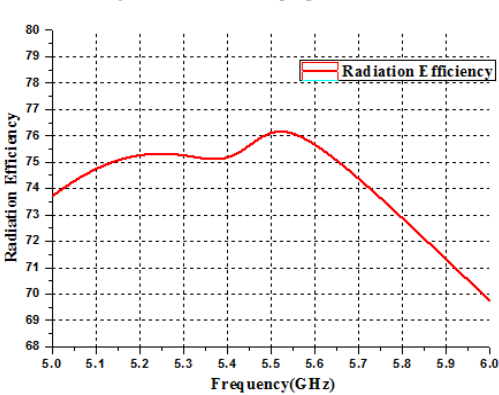
Fig. 10. VSWR of the proposed antenna.